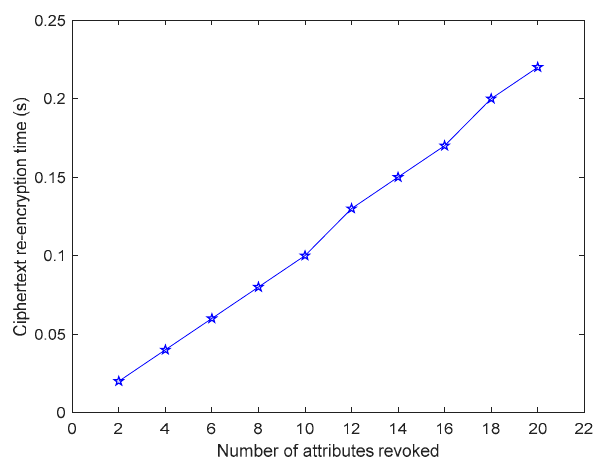
Figure 8. Time spent on ciphertext re-encryption.